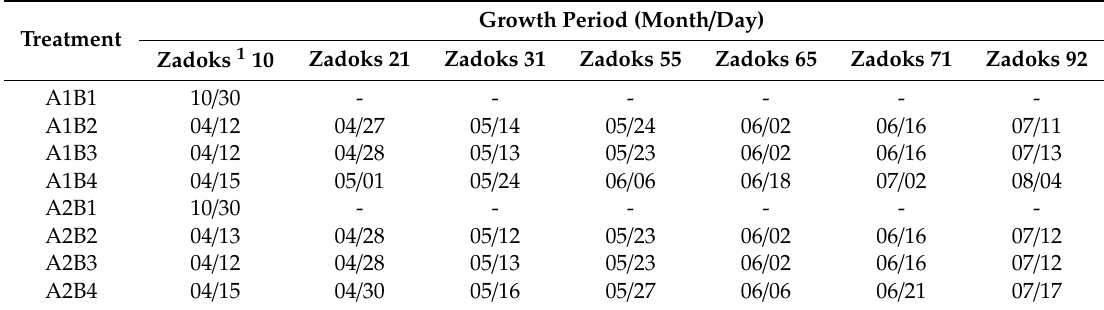
Table 6. The di ff erences in the growth of winter wheat sown on di ff erent dates (2013–2014). Treatment